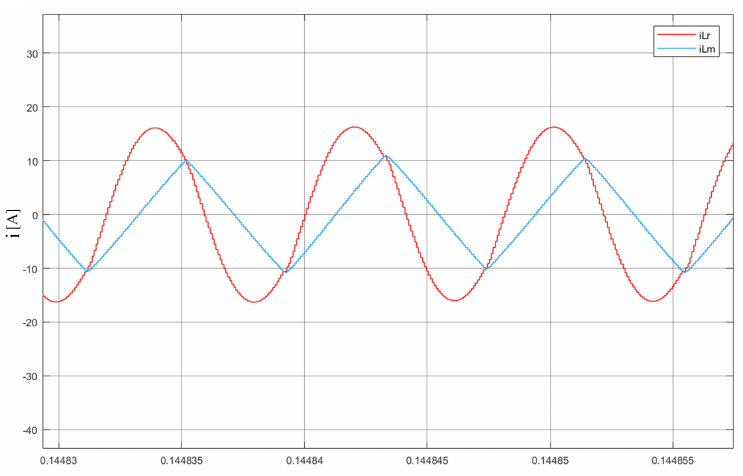
Figure 8. The waveforms of resonant current and magnetic